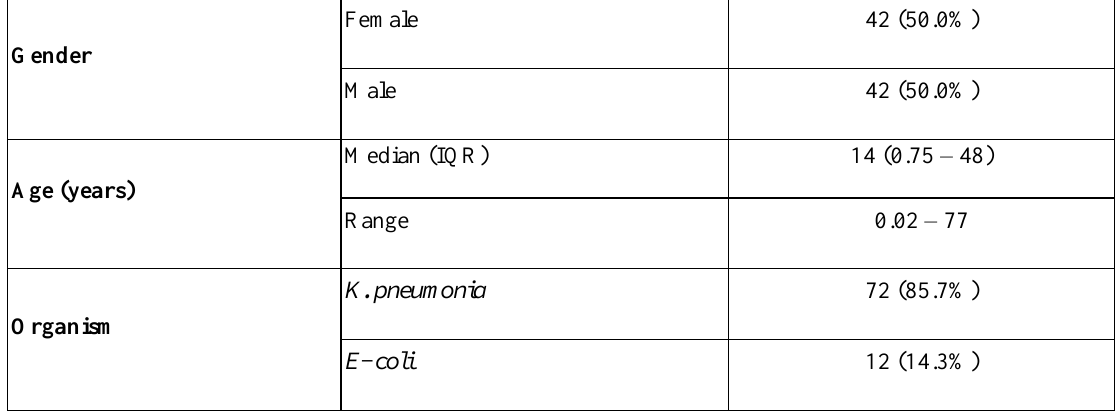
Table 2. Demographic data of included patients and type of isolates (84 isolates)